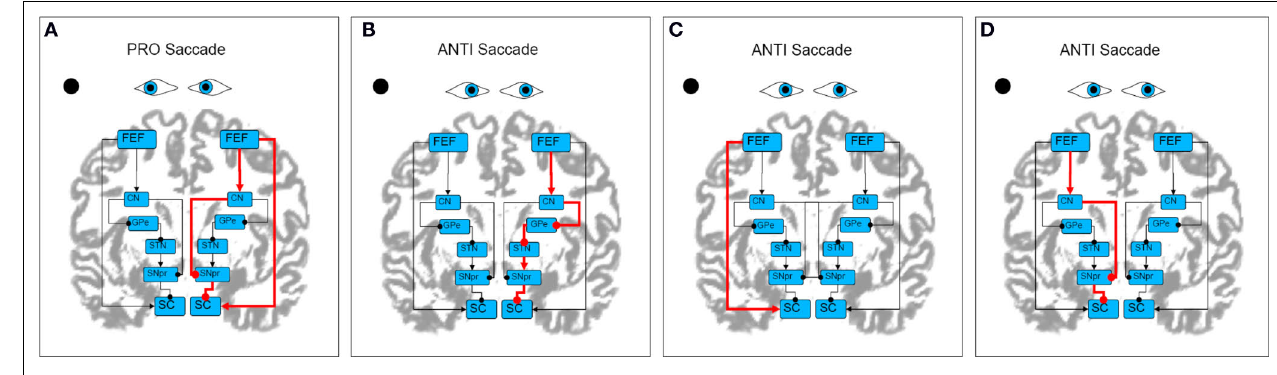
FIGURE 1 | Possible mechanisms for the FEF to regulate pro- and anti-saccade generation. The target is displayed as a black dot. For pro- saccades, the FEF contralateral to saccade direction can send a motor command directly to the SC in the same hemisphere and/or through the CN > SNpr (the so called ‘direct pathway’) (A) . For anti-saccades, more scenarios are possible: the FEF ipsilateral to saccade direction could